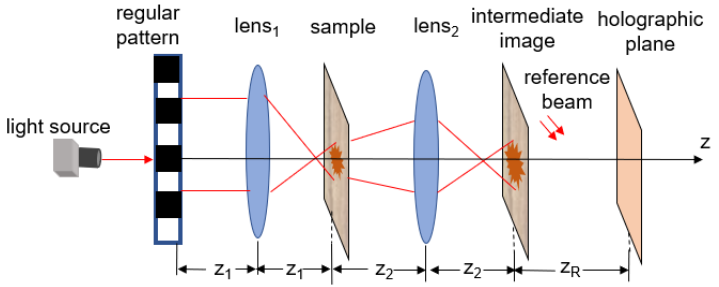
Figure 11. Schematic diagram of the resolution enhancement in lensless digital holographic micros- copy based on structured illumination.